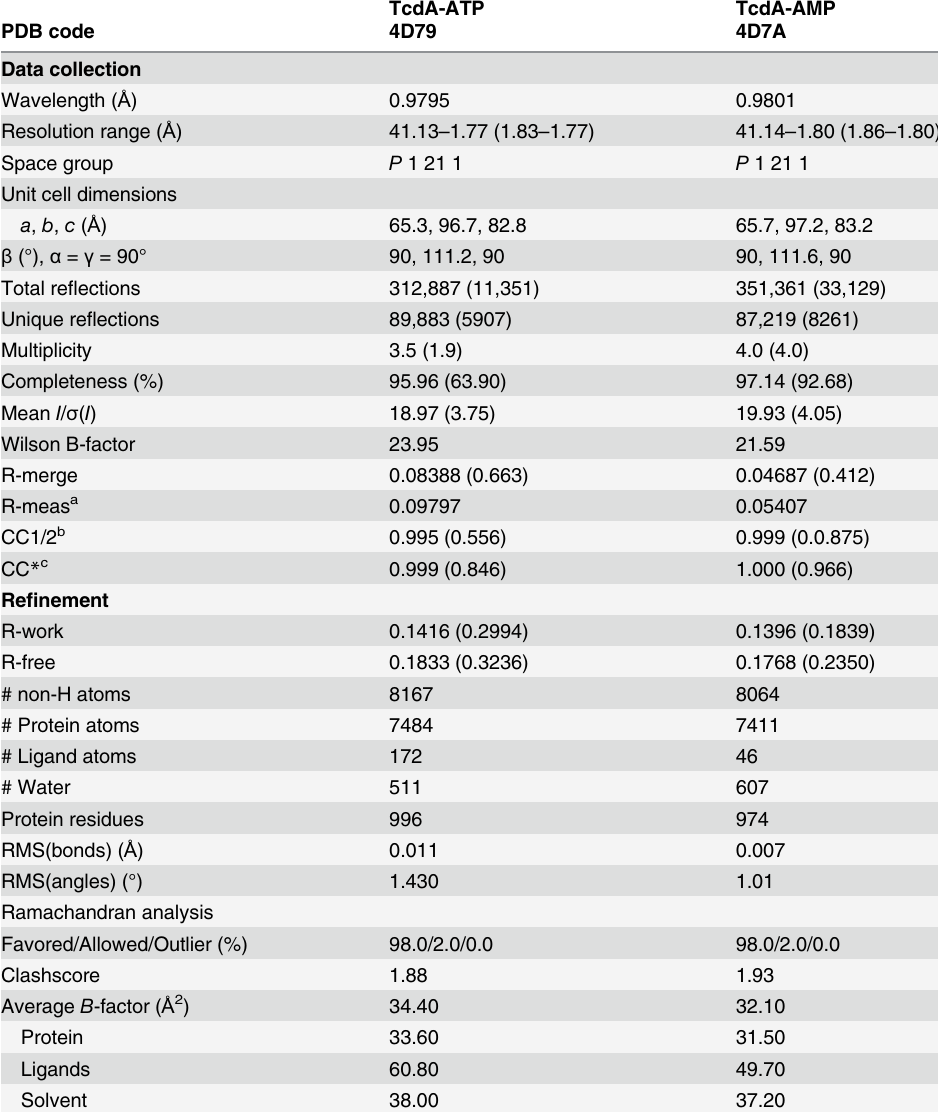
Table 1. Crystallographic data processing and refinement